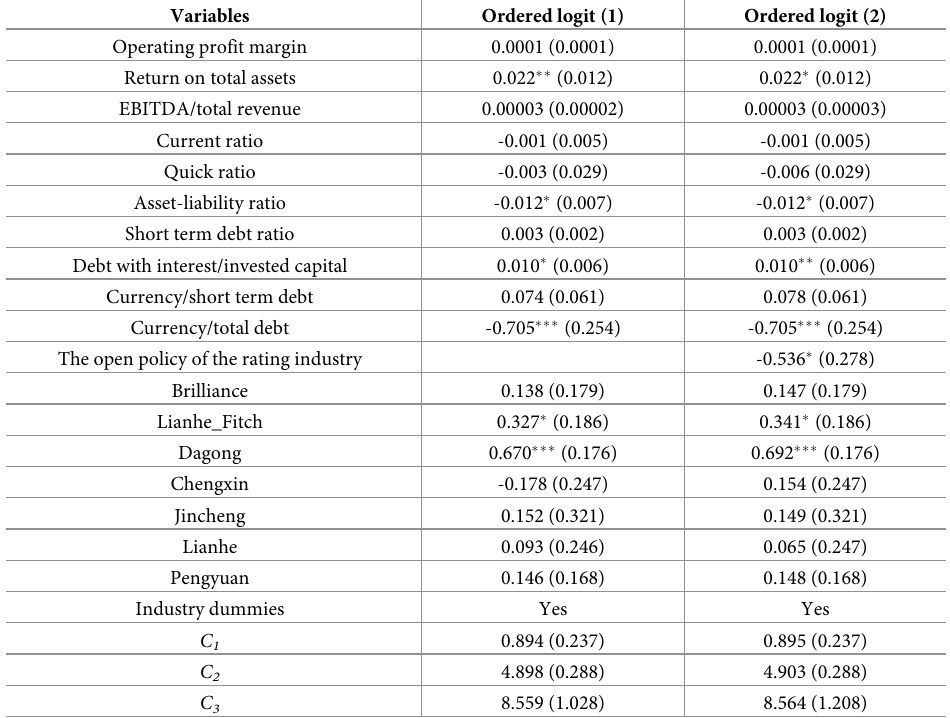
Table 9. Regression results of rating